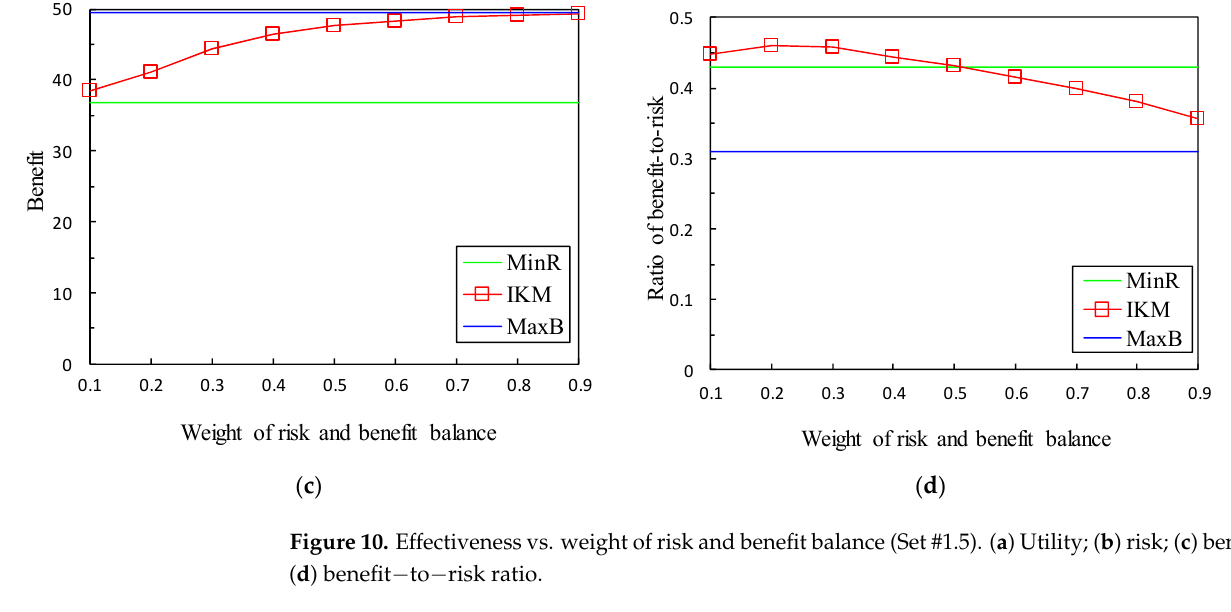
Figure 10. Effectiveness vs. weight of risk and benefit balance (Set #1.5). ( a ) Utility; ( b ) risk; ( c ) benefit; ( d ) benefit − to − risk ratio.